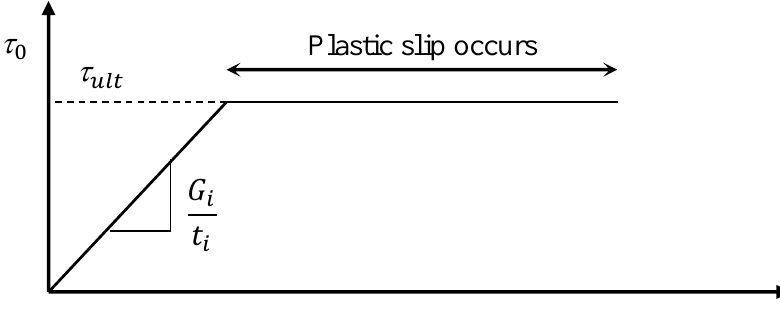
Figure 10. Shear stress versus pile–soil relative displacement.